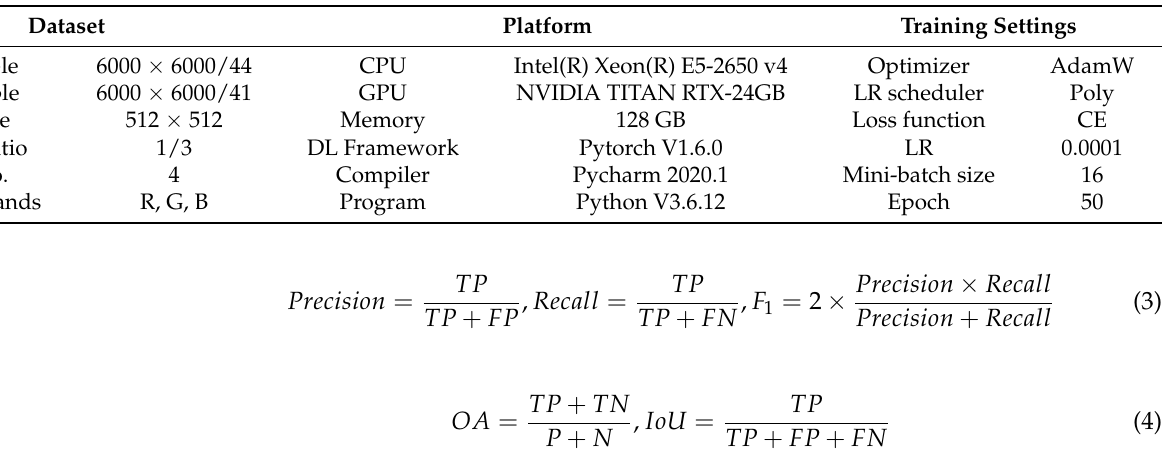
Table 2. Details of the experiment’s